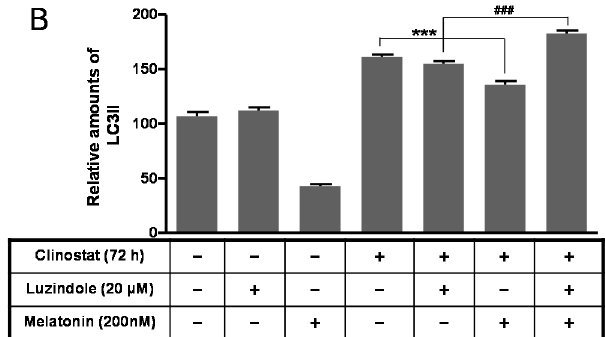
Figure 6. The expression of the LC3 protein with clinostat rotation and/or melatonin treatment and luzindole, melatonin receptor antagonist, in MC3T3-E1 cells. MC3T3-E1 cells were cultured in α -MEM added with 10% FBS at 37 °C with 5% CO 2 . To experimentally simulate microgravity with the 3D clinostat, cells were cultured in T-25 cell culture flasks completely filled with a 1:1 mixture of α -MEM and Leibovitz's L-15 supplemented with 10% FBS and 1% PS, with or without melatonin (200 nM) and/or luzindole (20 µM). LC3 expression was then performed by Western blot analysis ( A ); the relative expression of LC3 ( B ) was carried out as described in the Materials and Methods section. Values in representative results are shown as means ± SD of at least three independent experiments. *** p < 0.001, clinostat vs. clinostat and melatonin; ### p < 0.001, clinostat and luzindole vs. clinostat, melatonin, and luzindole.